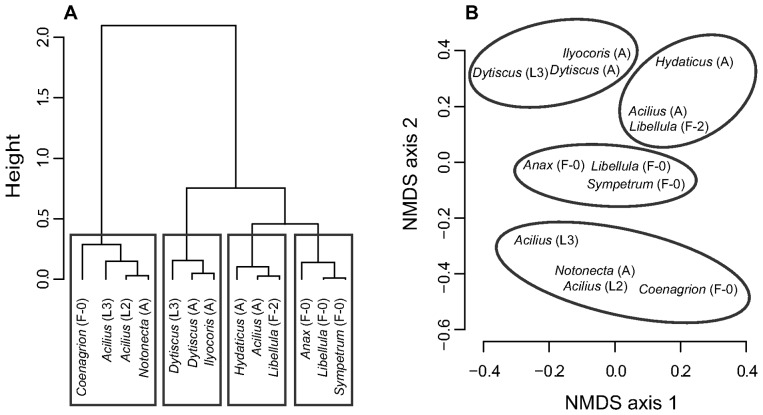
Similarity of diets of the predators used in the experiment.A. Ward’s hierarchical clustering of the diet dissimilarities Dij; height = value of clustering criterion for the particular cluster. B. Diet dissimilarities Dij visualised by nonmetric multidimensional scaling (NMDS, stress = 3.99), with groups identified by the cluster analysis highlighted; position of each species in the diagram corresponds to the centre of its label.